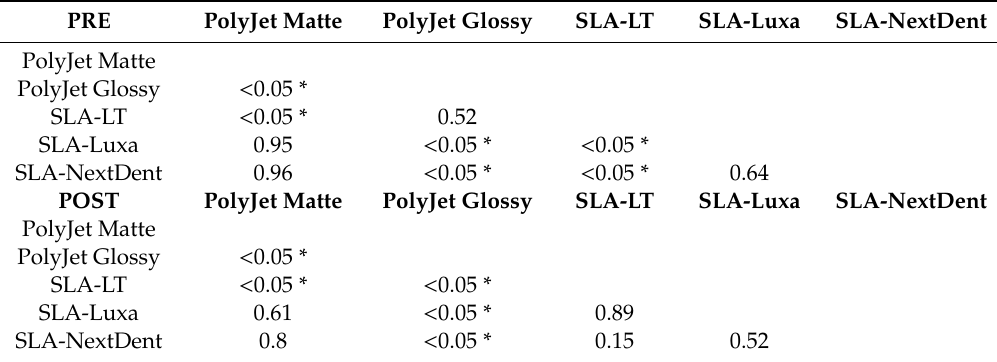
Table 5. Statistical comparison of overall pre- and post-sterilization